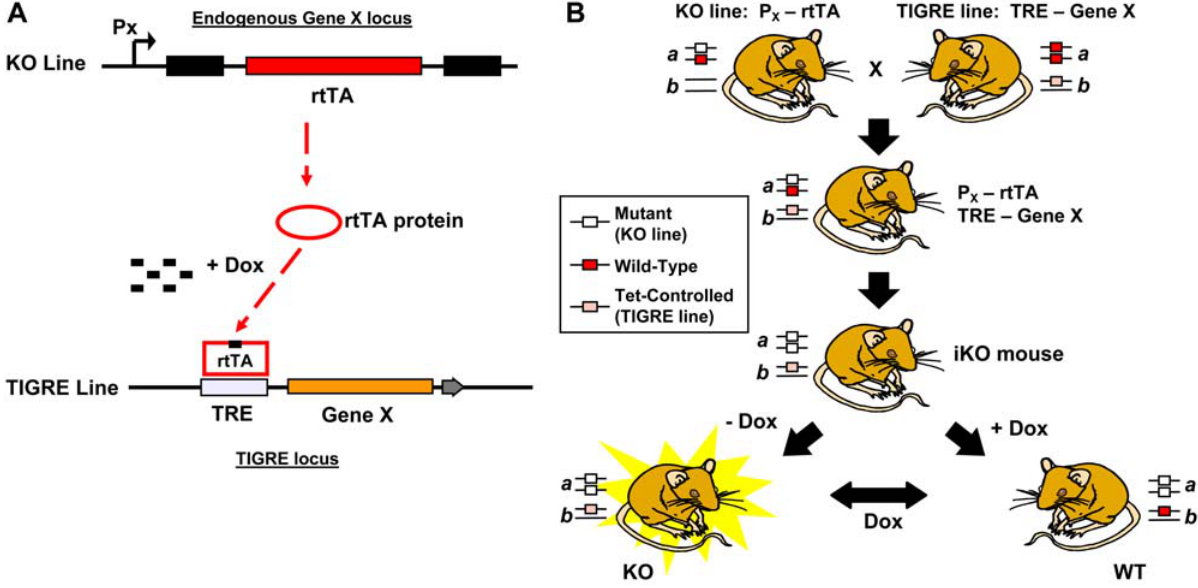
Figure 1. Schematic diagram of the principle of the iKO system. (A) Two components of the iKO system, a KO line and a TIGRE line. (B) Generation of iKO mouse by crossing the KO and TIGRE lines. The iKO is a composite mouse in which: 1) both copies of the endogenous Gene X are disrupted by the insertion; 2) rtTA is driven by the promoter of Gene X; and 3) the cDNA of Gene X is in the TIGRE locus under the control of TRE. Functional Gene X is only expressed from the TIGRE locus when rtTA is bound to Dox, and therefore is inducibly and reversibly regulated by Dox.